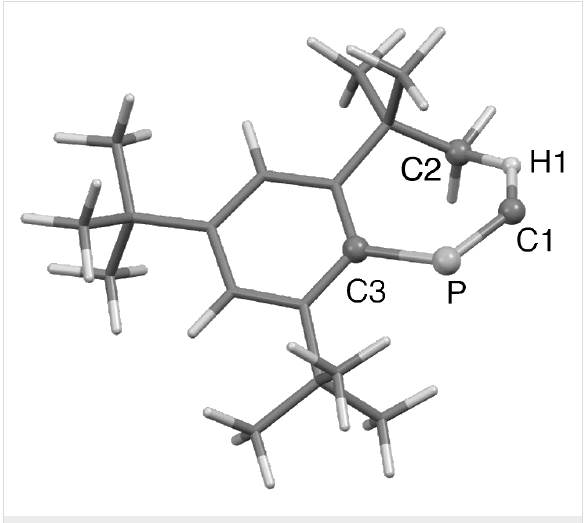
Figure 1: Optimized structure of the transition state (TS) for the intramolecular C–H insertion of 1 [MP2(Full)/6-31G(d)]. Bond lengths (Å): P–C1 1.660, C1–H1 1.228, C2–H1 1.281, P–C3